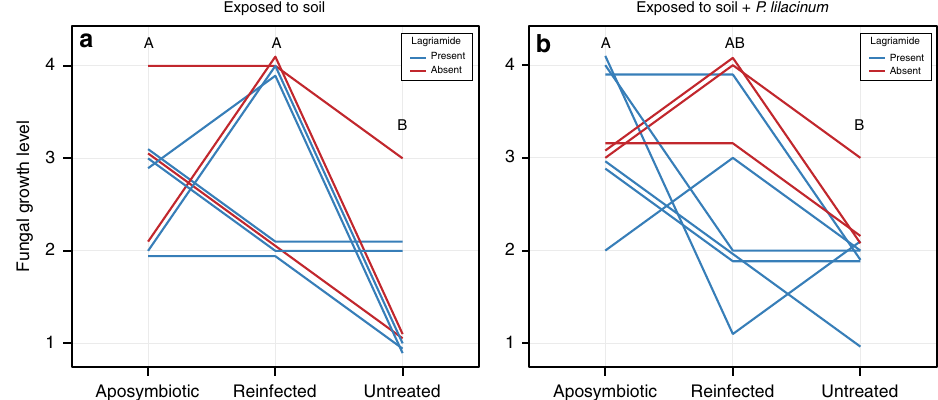
Fig. 6 Egg clusters lacking the native symbionts are more vulnerable to fungal infection in fi eld-collected soil. a Egg clusters exposed to untreated fi eld- collected soil ( N = 8 egg clutches, Friedman χ 2 (2) = 10.57, p = 0.005; Nemenyi: A vs. B p < 0.05). b Egg clusters exposed to fi eld-collected soil inoculated with P. lilacinum spores ( N = 9 egg clutches, Friedman χ 2 (2) = 7.47, p = 0.024; Nemenyi: A vs. B p < 0.05). Fungal growth was estimated qualitatively during blind monitoring of egg clutches using subsets that were either aposymbiotic (symbiont-free), reinfected with a previously recovered egg-wash (reinfected), or untreated (symbiotic), and exposed to soil from their natural environment. The level of growth (1 – 4) corresponded to increasing amount of fungal biomass visible on the egg surface. Each line corresponds to an independent egg clutch and the color of the line represents absence (red) or presence (blue) of lagriamide in untreated eggs of the corresponding